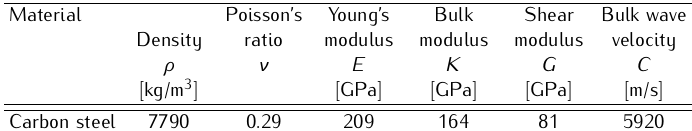
Table 1. Material parameters of the investigated materials.